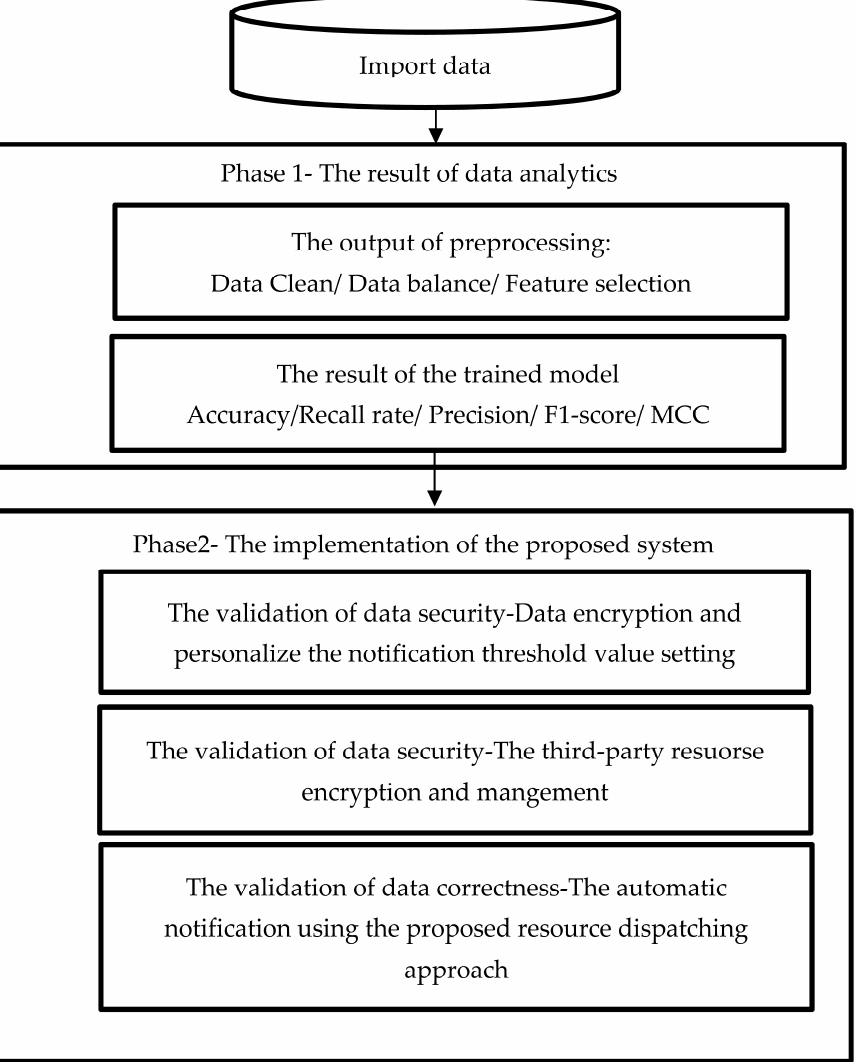
Table 1. The description of experiment environment.